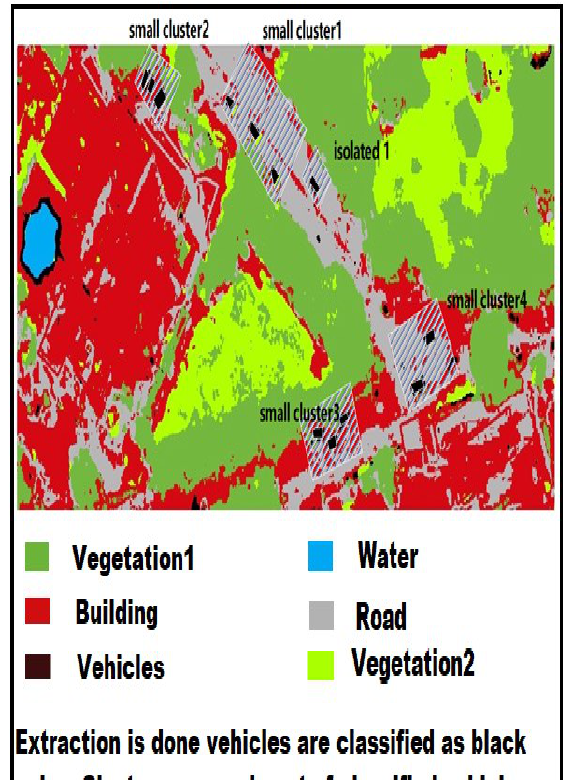
Figure 5. Cluster formation from classified vehicles.